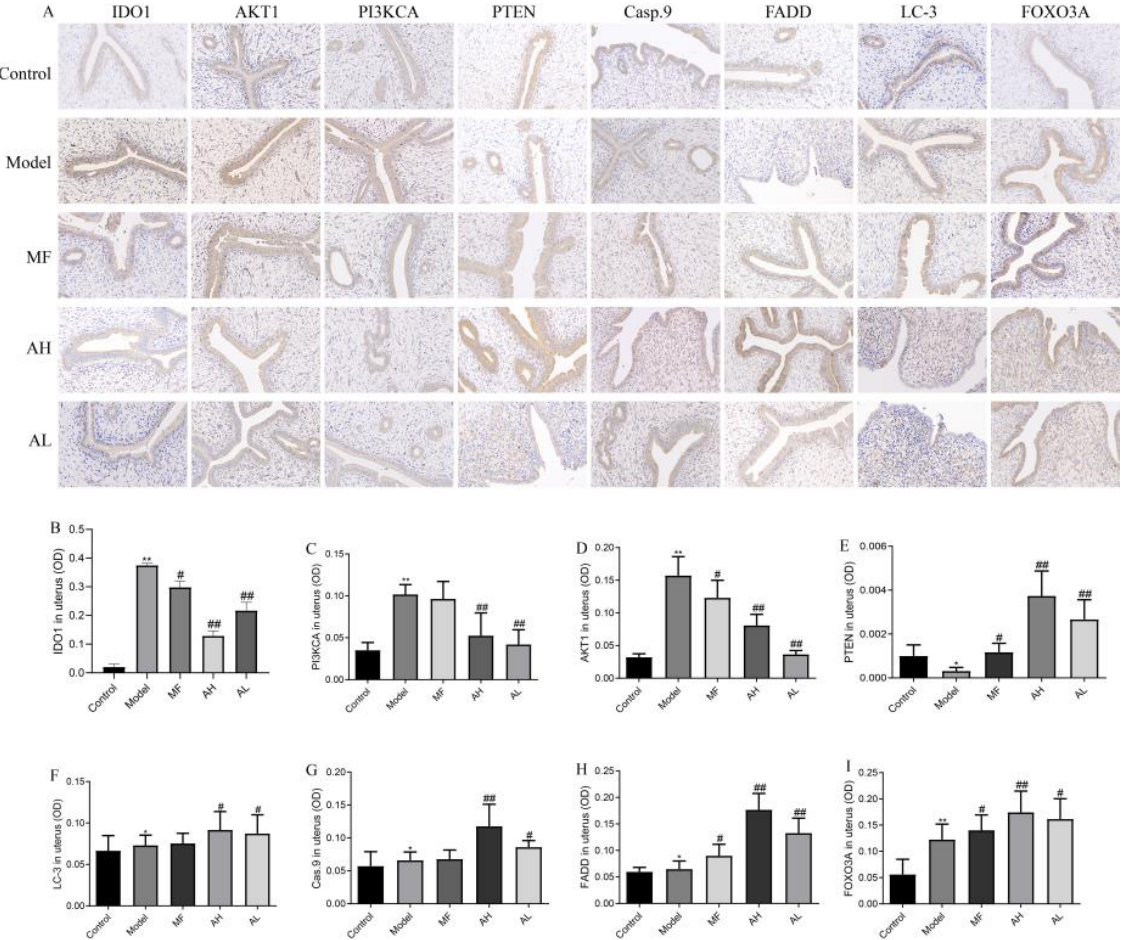
Figure 10. Protein expression of IDO1, PI3KCA, AKT1, PTEN, caspase-9, FADD, LC-3, and FOXO3A in rat uterine tissues by immunohistochemistry ( × 200). ( A ) Representative images of immunohistochemistry results. ( B ) Statistical results of IDO1 protein. ( C ) Statistical results of PI3KCA protein. ( D ) Statistical results of AKT1 protein. ( E ) Statistical results of PTEN protein. ( F ) Statistical results of LC-3 protein. ( G ) Statistical results of Casp.9 protein. ( H ) Statistical results of FADD protein. ( I ) Statistical results of FOXO3A protein. The data are presented as the mean ± SD ( * p < 0.05, ** p < 0.01 compared with the control group; # p < 0.05, ## p < 0.01 compared with the model group).